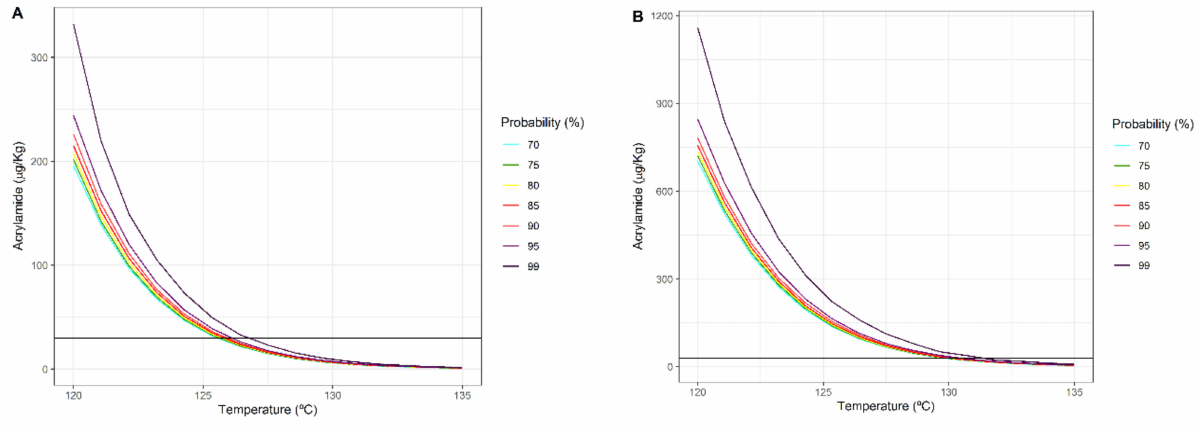
Figure 7. Acrylamide formed as a function of time for each temperature and P ( log 10 S ≥ 6 ) : potato puree ( A ) and prune juice ( B ).